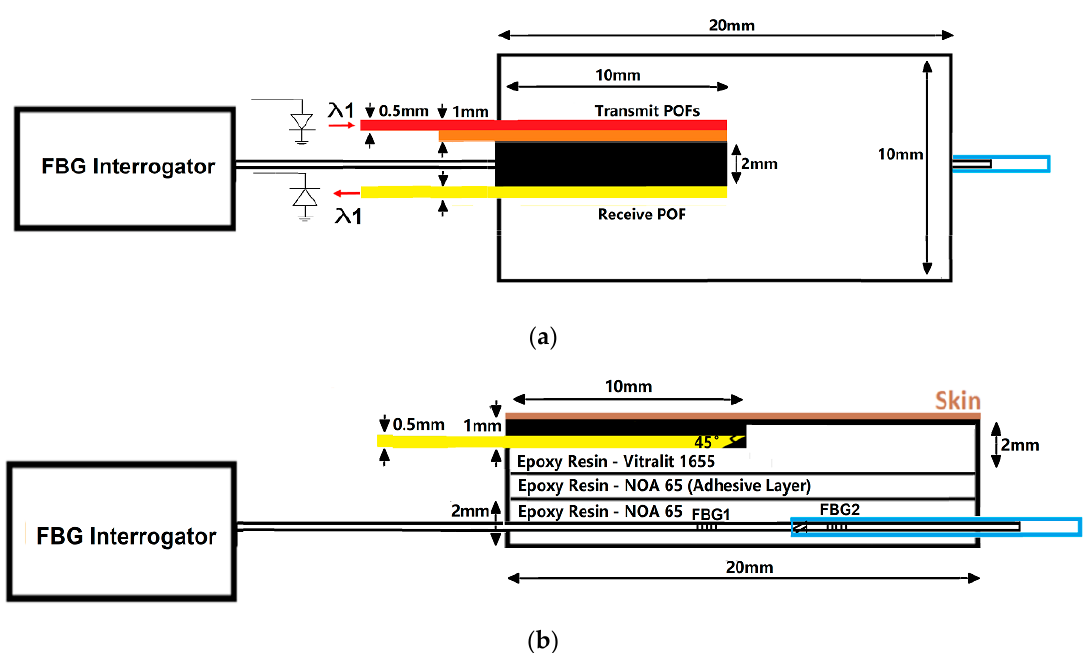
Figure 1. ( a ) Schematic diagram of a plane view of the probe. The red frame represents the POF